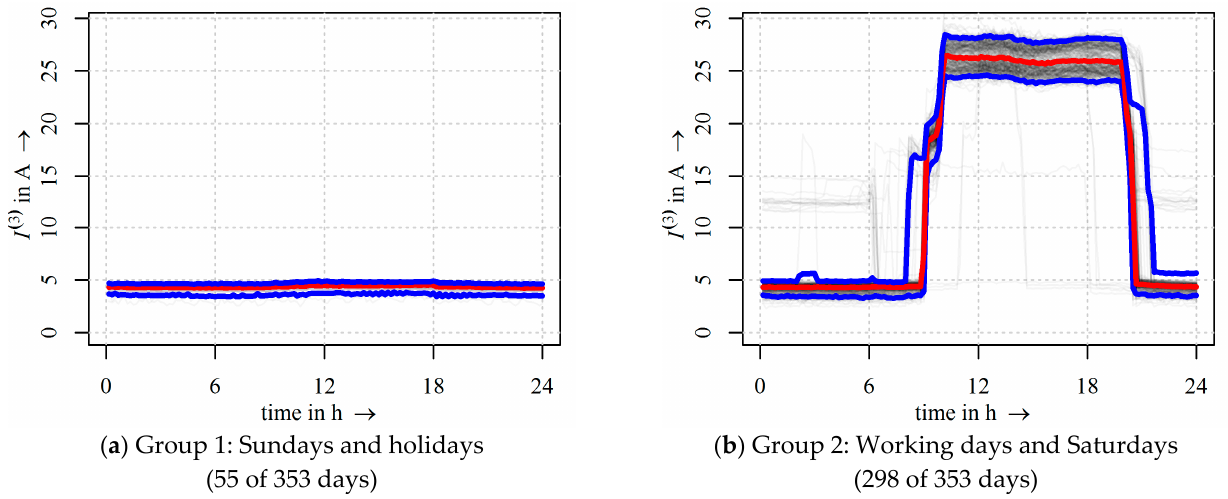
Figure 3. Profile of the 3rd harmonic current for an electronic market; median (red), 5th and 95th percentile (blue), daily time series (grey); aggregation interval: 10 min; measurement duration: 353 days from January to December 2012.